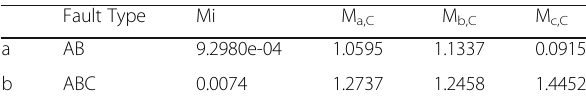
Table 7 Results of two fault cases during current transformer